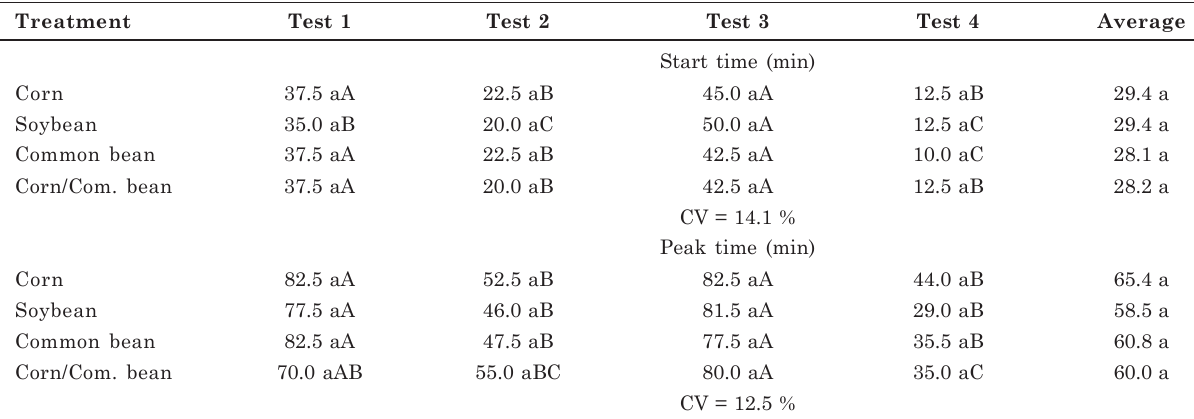
Table 2. The time runoff began and time of peak runoff, under four treatments and rainfall tests, on a Humic Dystrudept